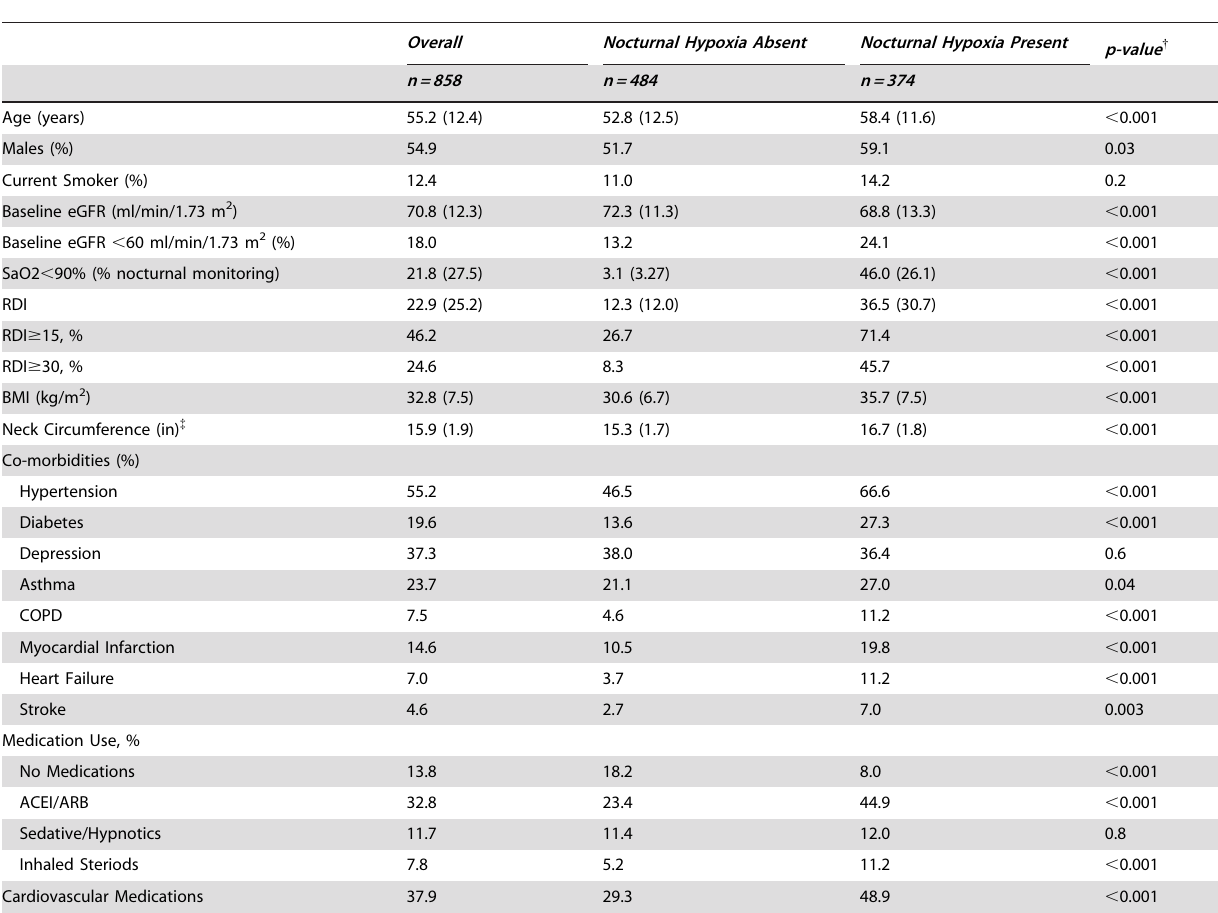
Table 1. Baseline subject characteristics, overall and by presence of nocturnal